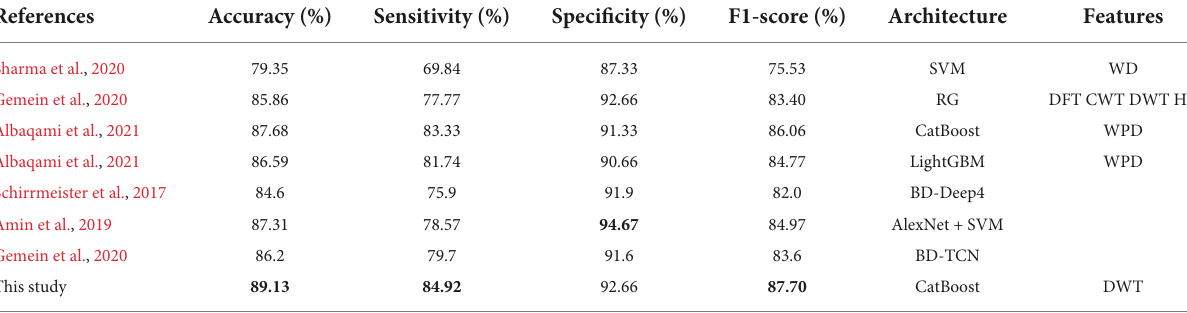
TABLE 4 Performance comparison of our proposed approach with previous